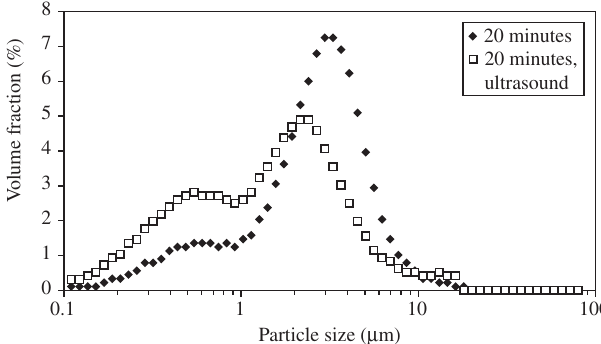
Figure 3. PSD curves of copper particles produced in Test 11, collected after 20 minutes of reaction time, before and after application of ultrasound (5 minutes).